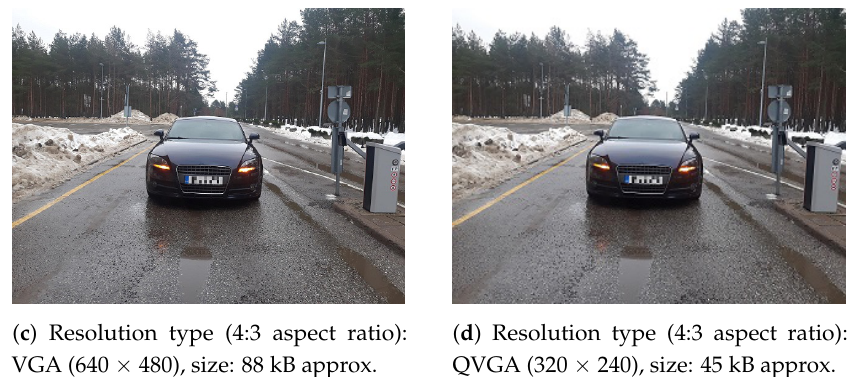
Figure 9. Images of different resolutions and sizes as generated by the field-deployed DVN at the entrance barrier of the TalTech